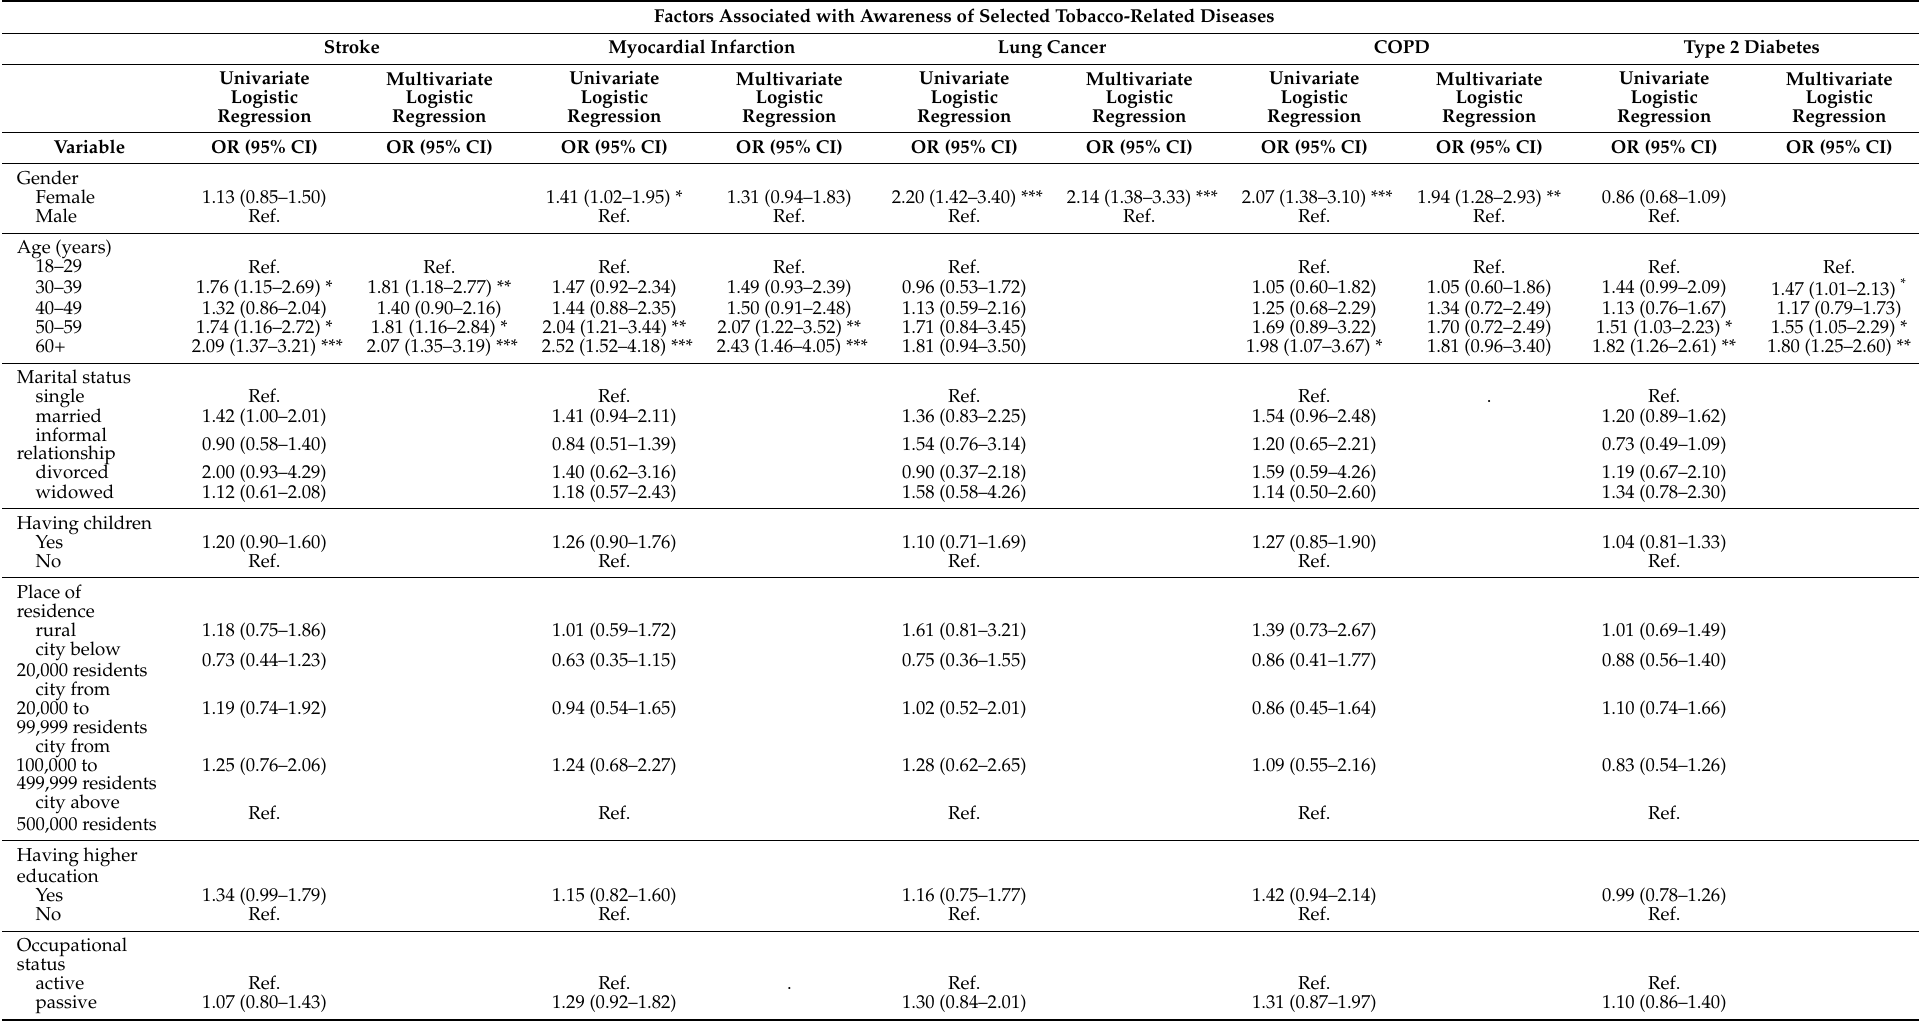
Table 4. Factors associated with awareness of selected tobacco-related diseases: odds ratios (OR) and 95% confidence intervals (95% CI), n =